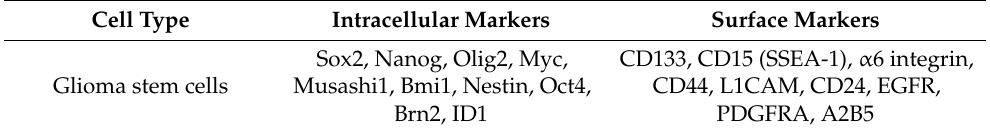
Table 2. Molecular markers of the glioma stem